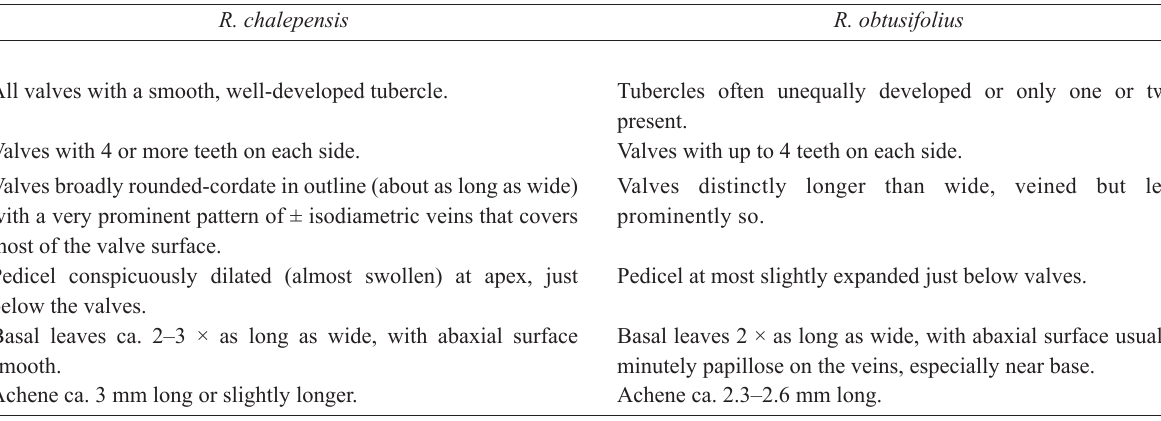
Figure 3. Rumex obtusifolius from Morocco (Taourirt, 17 June 2019); A, detail of infructescence with valves longer than wide; B, papillose abaxial side of the leaves. (Photos M. Chambouleyron).